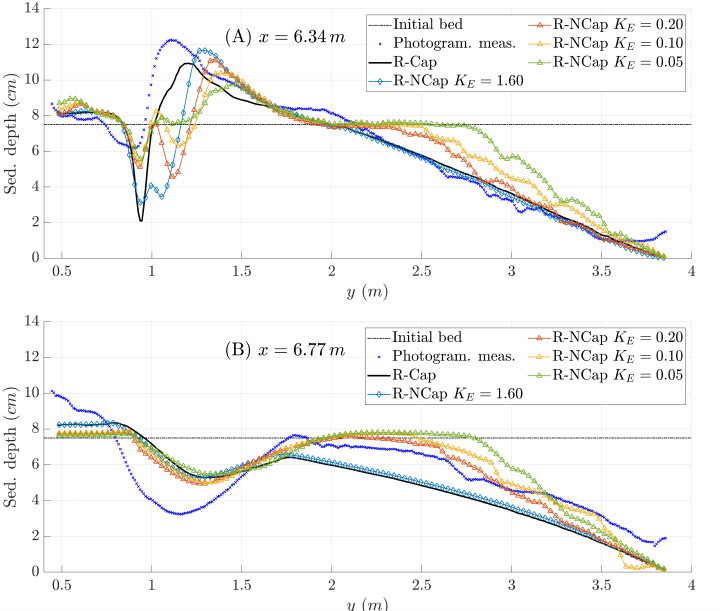
Figure 8. Final bed level profiles along x = 6.34 m ( A ) and x = 6.77 m ( B ) with the R-NCap model. Experimental photogrammetric data and results from the R-Cap model are also